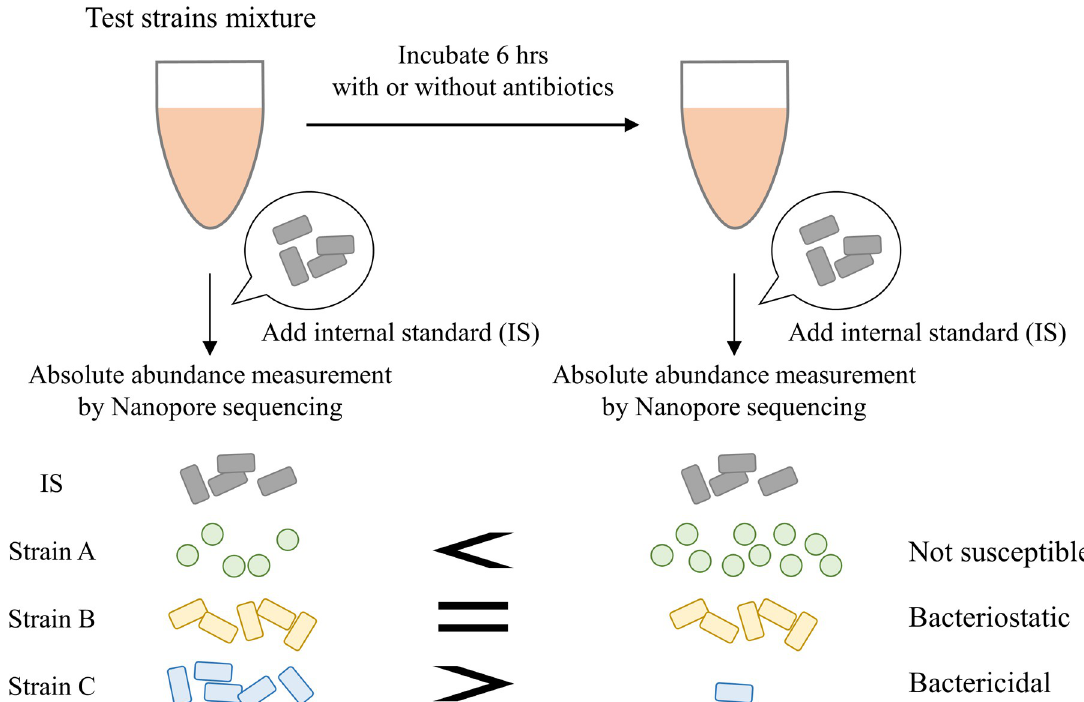
Fig 1. Design of antimicrobial susceptibility testing methodology. A culture containing several test strains were prepared, and the absolute abundances of each test strains before and after exposure to antimicrobials was measured by 16S rRNA amplicon sequencing. Internal standard bacteria were added to the culture before DNA